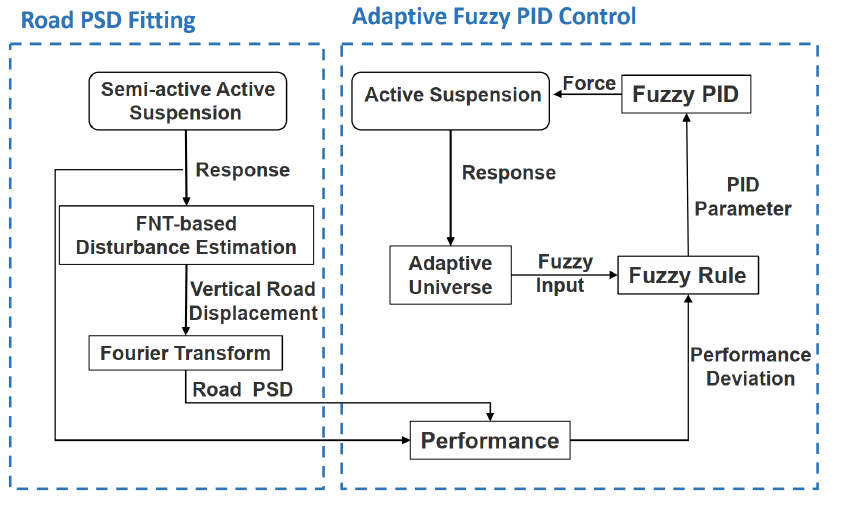
Figure 2. The general